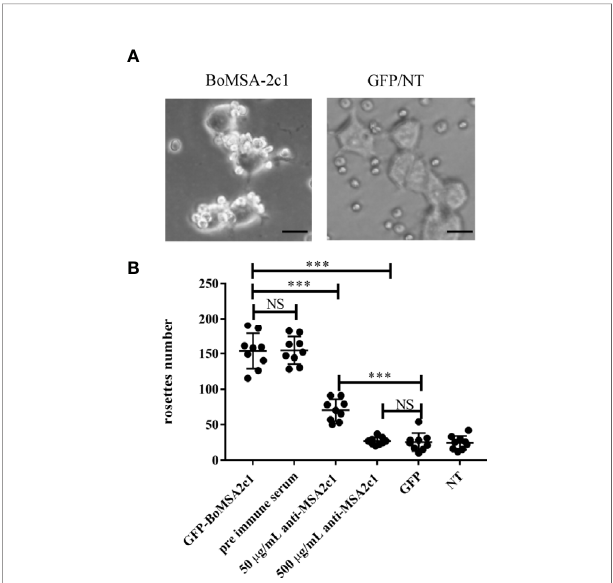
FIGURE 5 | Rosette assays of binding and inhibition of BoMSA-2c1. (A) Rosettes formed by HEK 293T cells transfected with BoMSA-2c1. Positive reaction has been de fi ned as the observation of coverage of > 50% of the transfected cell surface with erythrocytes. Negative controls include empty pEGFP-NI vector/non-transfected cells (GFP/NT). (B) Numbers of rosettes formed by HEK 293T cells transfected with genes encoding BoMSA- 2c1. Positive reaction has been de fi ned as the clustering of ≥ 5 RBCs with the transfected cells, and rosettes were scored in 10 consecutive fi elds at 200x magni fi cation in each construct. Cells were subsequently incubated with anti-rBoMSA-2c1 rabbit sera at two dilutions before the addition of water buffalo erythrocytes. Pre-immune rabbit sera diluted 1:100, empty pEGFP-NI vector (GFP), and non-transfected (NT) cells were used as controls. Data were analyzed using one-way analysis of variance (ANOVA), followed by Tukey ’ s multiple comparison tests. Results are shown as mean ± SD (shown as error bars). NS, not signi fi cant at P > 0.05. Signi fi cant at ***P < 0.001. Scale bars: 40 µm.